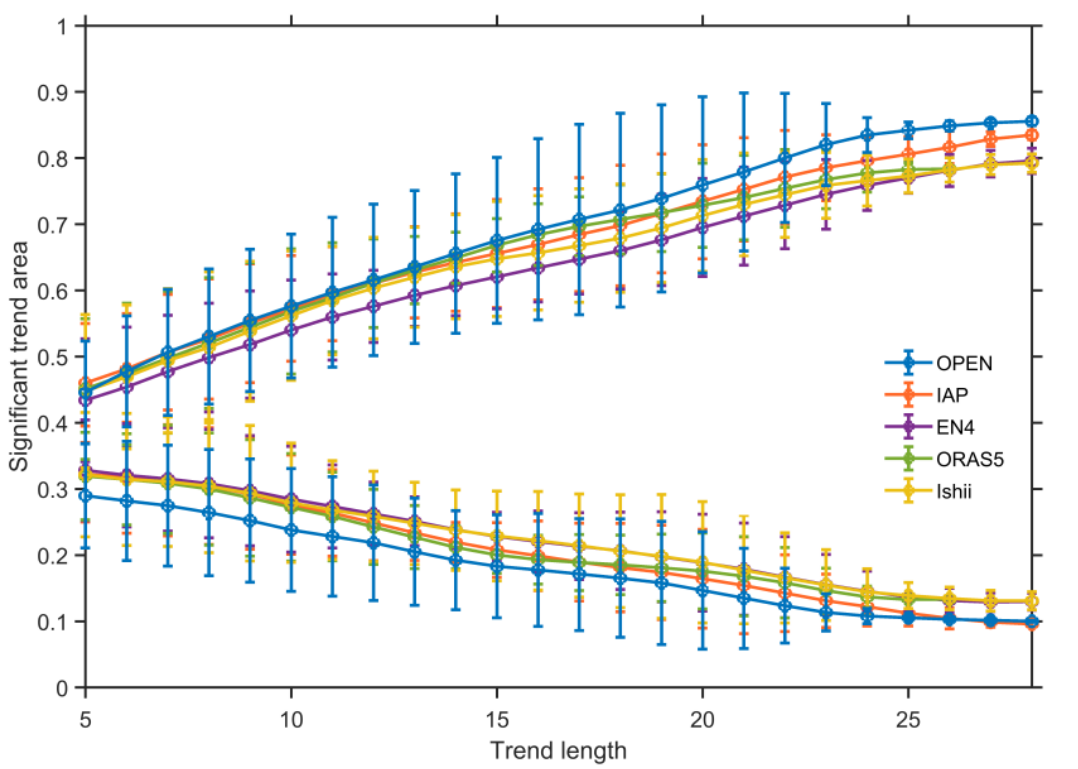
Figure 6. Area proportion of the global ocean that is significantly warmed (upper lines) versus cooled (lower lines), based on the OHC trends have passed the significance test. The monthly OPEN, IAP, EN4, ORAS5, and Ishii datasets from 1993 to 2021 were used. Means and uncertainties were estimated using the length of consecutive periods from 5 to 29 years. Error bars indicate 95% two-sided confidence